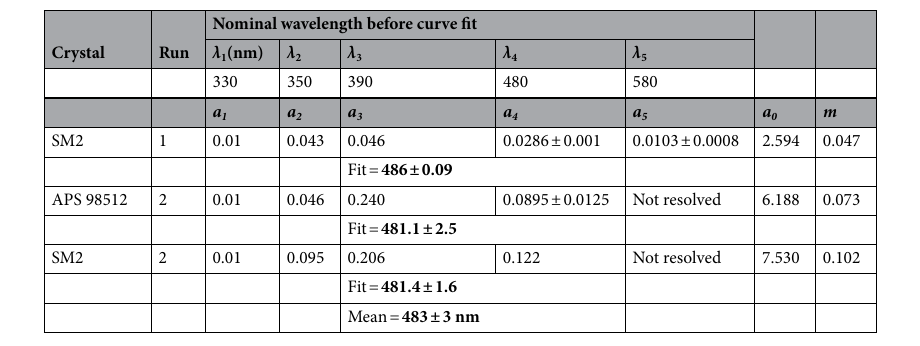
Table 3. Fit coefficients for absorbance